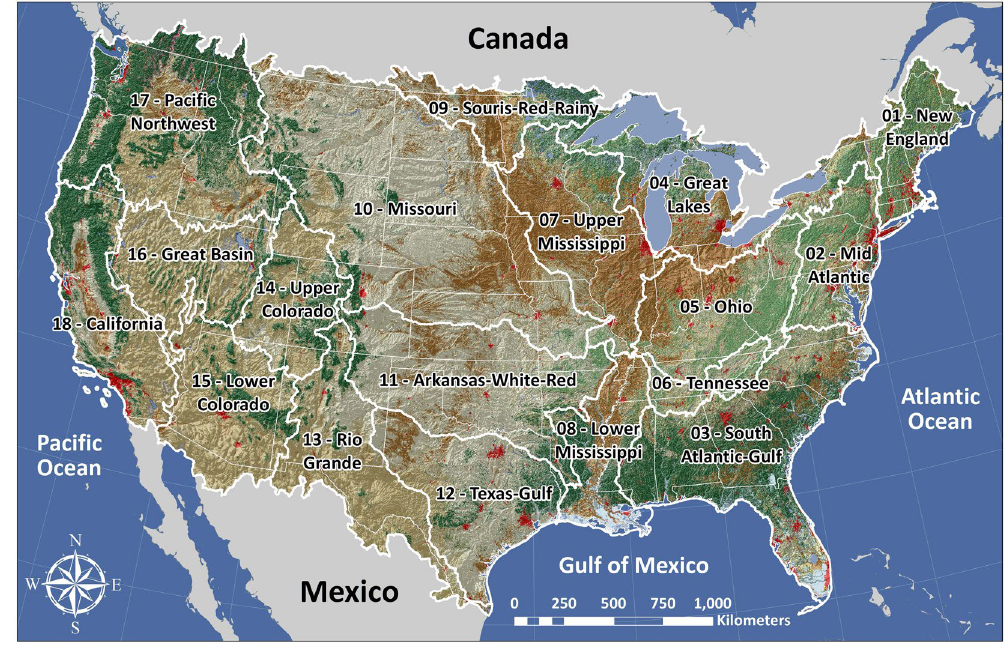
Figure 1. Map of 18 HUC 2-digit basins covering the contiguous US (Created using ArcGIS 10.4: http:// desktop.arcgis.com/en/arcmap/10.4/get-started/main/get-started-with-arcmap.htm) 26